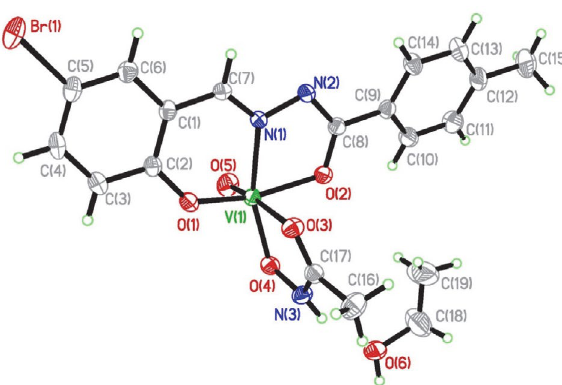
Figure 1. An ORTEP diagram of complex 1 with atom labeling scheme and 30% probability thermal ellipsoids for all non-hydro- gen atoms. Hydrogen bonds are shown as dashed lines.